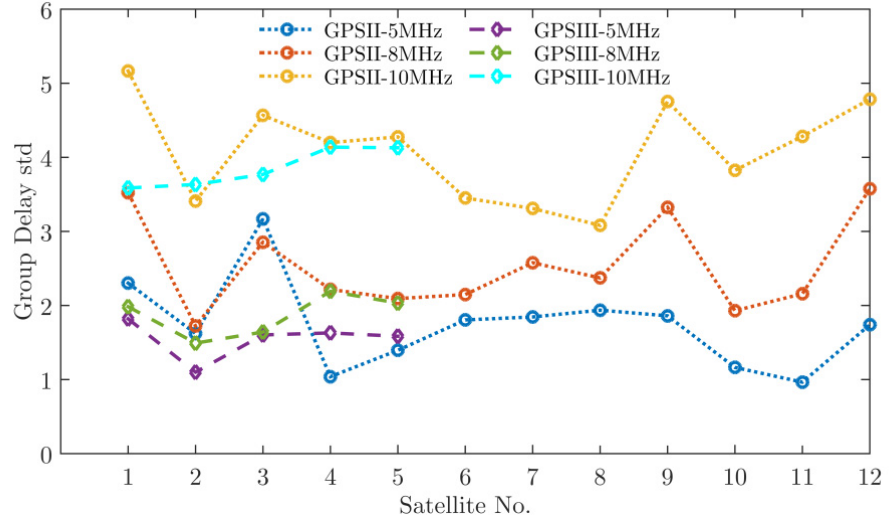
Figure 13. Standard deviations of group delay under different bandwidths.